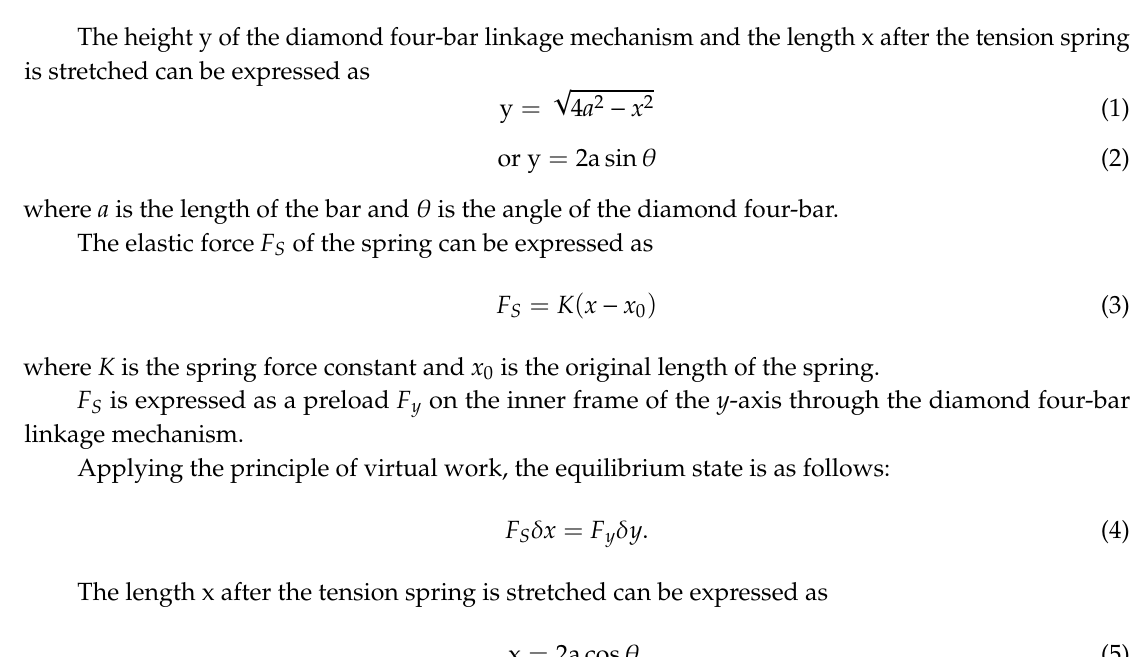
Figure 3. A simplified model of the diamond four-bar linkage mechanism.